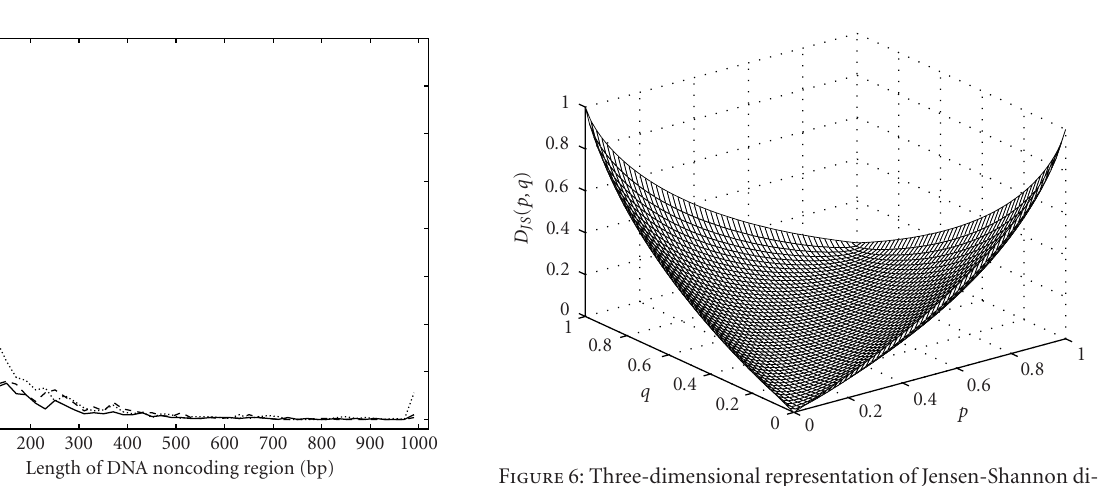
Figure 6: Three-dimensional representation of Jensen-Shannon di- vergence D JS ( p , q ), where p = ( p ,1 − p ), q = ( q ,1 − q ), and π = (0 . 5,0 .